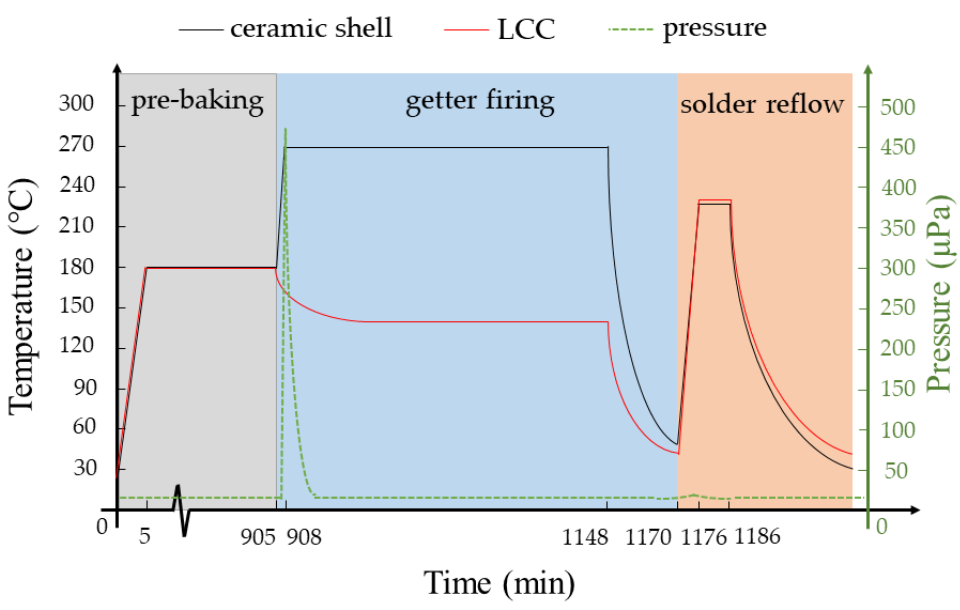
Figure 11. Temperature and pressure profile during vacuum